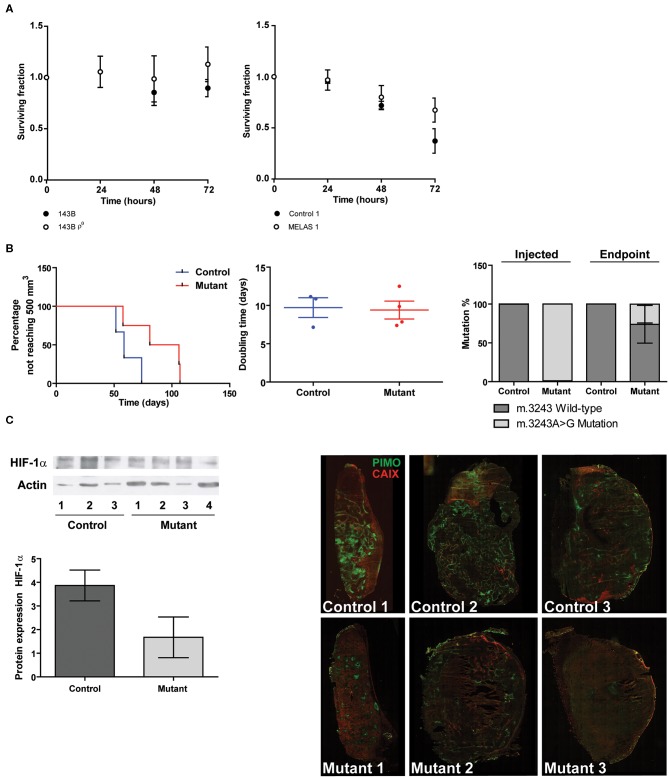
Functional consequences of mtDNA mutations in relation to hypoxia. (A) Hypoxia tolerance. Data represents the mean of ≥3 independent biological repeats ± SEM. (B) Percentage not reaching 500 mm3 (left panel), Doubling time (middle panel), and mutation percentage before injection and after tumor excision (right panel). (C) Representative Western blot and quantification of HIF-1α protein expression (left). Immunohistochemisty (right) of hypoxia assessed using pimonidazole (green) and CAIX (red).